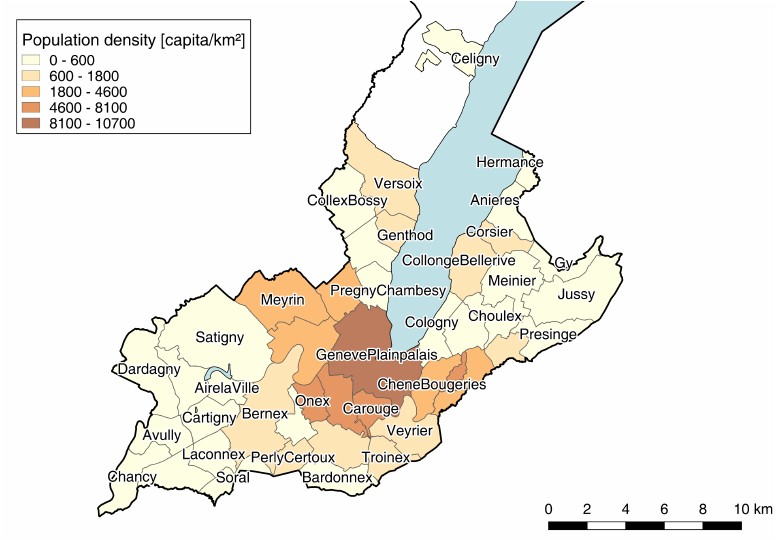
Figure 6. Population density of communes in the canton of Geneva.